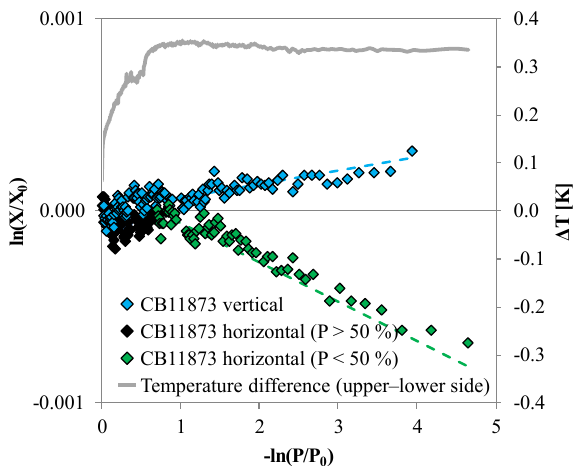
Figure 9. CO 2 measurements of high-flow experiments with CB11873 corrected for Langmuir adsorption–desorption effects based on the low-flow experiments; the vertically positioned cylin- der is shown in blue and the horizontally positioned cylinder is shown in black for the first half and green for the second half of the run. The data are plotted such that fractionations caused by Rayleigh distillation would follow a line with slope 1 α , with α be- ing the fractionation factor. These lines are indicated by the dashed lines in corresponding colors that were calculated based on an av- eraged α from all available experiments. The grey line plotted on the secondary y axis is the temperature difference between T15 and T16 corresponding to the upper and the lower side of the horizon- tally positioned cylinder. It reaches its maximum after the cylinder is about half empty, which is when the fractionation seems to